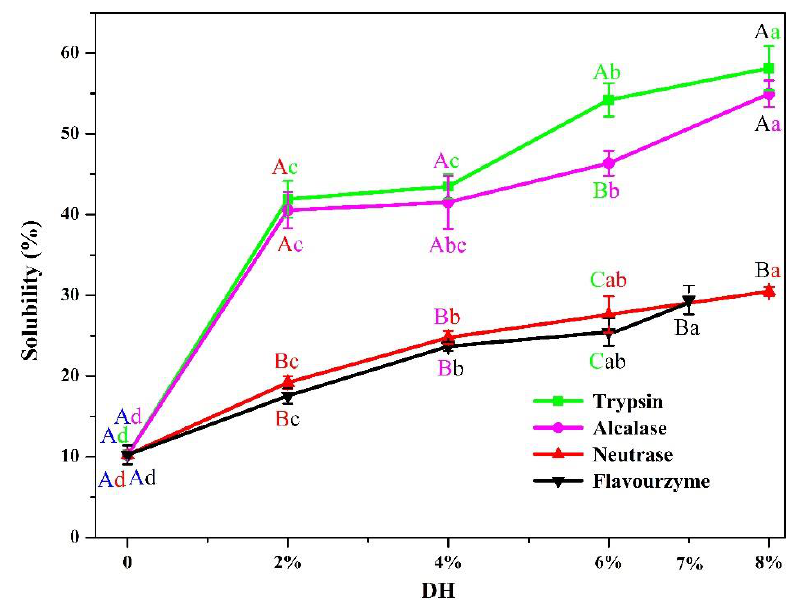
Figure 7. Solubility of PP and PP with different DH samples. Different lowercase letters are used to indicate the significant differences ( p < 0.05) of the same enzyme under different DH , while different uppercase letters are used to indicate the significant differences ( p < 0.05) of different enzymes under the same DH .